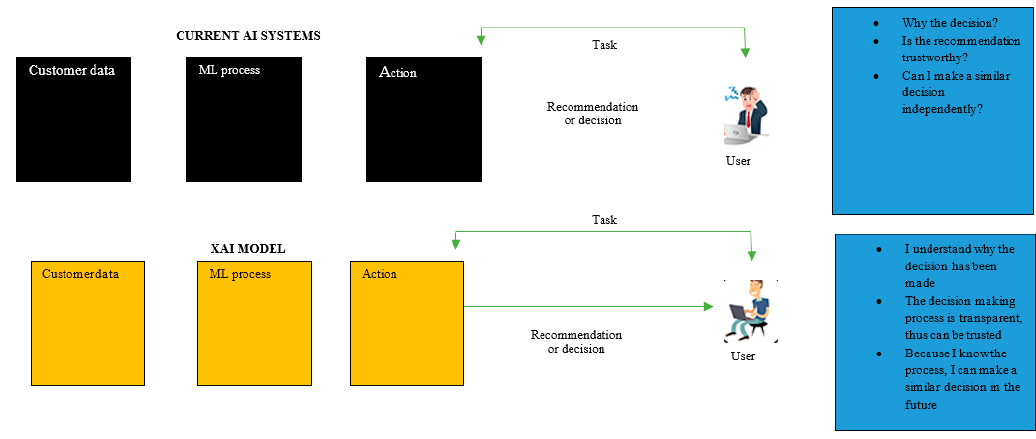
Figure 6. An analogy showing the differences between present-day AI and XAI models.